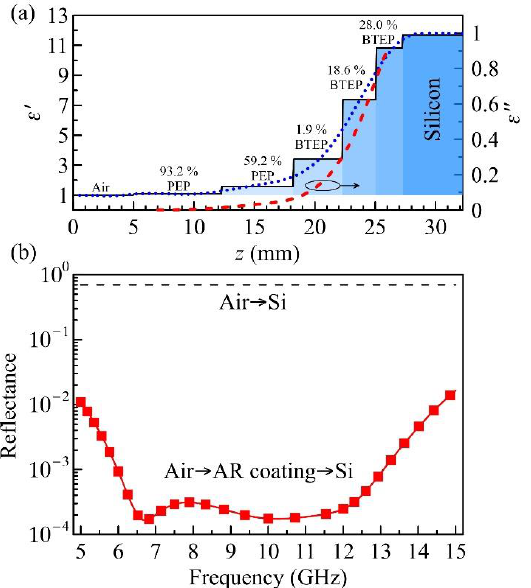
Figure 6. ( a ) Permittivity profile of the antireflection coating. The doping volume fraction and composite type of each layer are indicated. The continuous complex permittivity profile (blue dots for ε (cid:48) and red dashed for ε (cid:48)(cid:48) ) is the fitting result of a 10-order polynomial. ( b ) Reflectance of silicon substrate coated with and without antireflection coating (red squared and black dashes, respectively). Symbols are the HFSS simulation results. Table 3. Parameters of the 5-layer antireflection coating for matching free space and silicon as schematically illustrated in Figure 6a. i denotes the layer number. PEP (BTEP) represents the po- rous epoxy (BaTiO 3 – epoxy) composite.